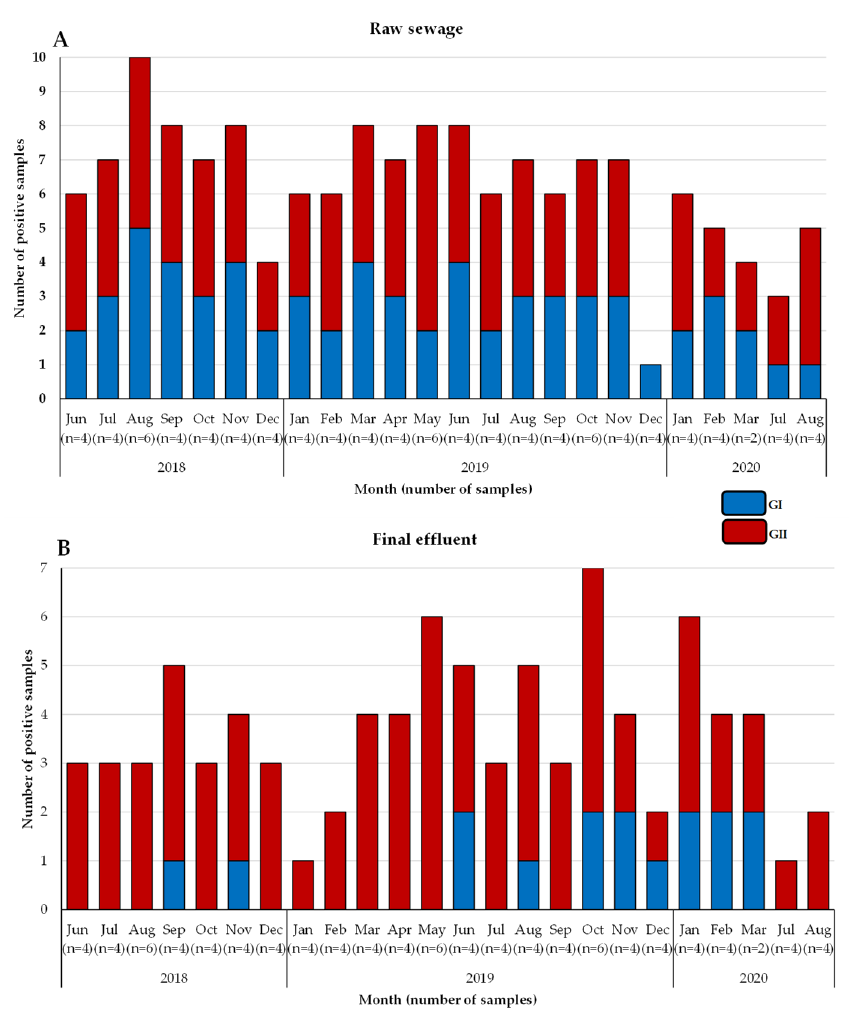
Figure 1. Distribution and prevalence of norovirus GI and GII in wastewater samples. Norovirus GI and GII detected in raw sewage ( A ) and final effluent ( B ) samples collected between June 2018 and August 2020. The numbers in parentheses indicate the number of samples collected in each